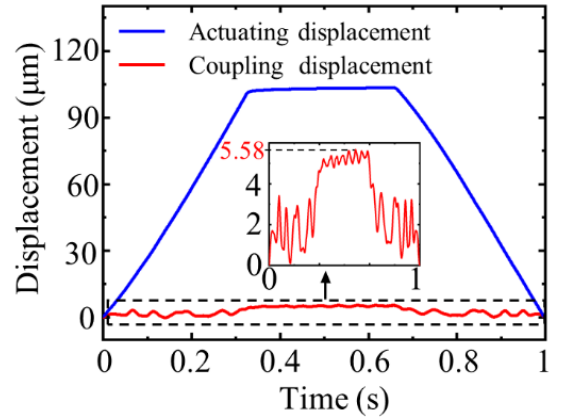
Figure 10. Non-driven displacement of the actuator. Figure 10. Non ‐ driven displacement of the actuator. The resonance frequency of the actuator was measured by an impedance analyzer. By applying a sweep sinusoidal wave with an amplitude of 1 V and a frequency range of 100~800 Hz to the PZT stack, the curve between the impedance angle and the frequency was generated by impedance analyzer, as shown in Figure 11. The first two resonance frequencies of the actuator are 377.2 and 472.6 Hz, with errors of 3.15% and 12.54%, respectively, compared with the first two resonance frequencies calculated by the finite element